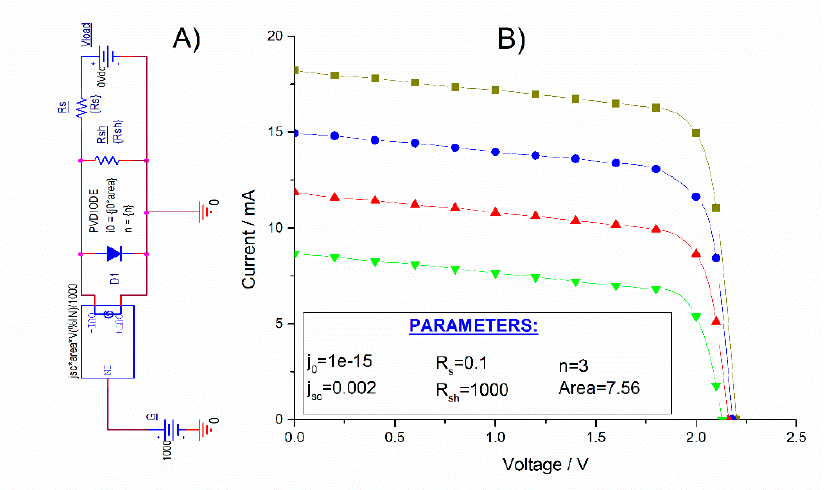
Figure 6. ( A ) Equivalent circuit used for the modeling of organic solar cells. ( B ) Generated I–V curves for different irradiance values: Green line (600 Wm − 2 ), red line (800 Wm − 2 ), blue line (STC 1000 Wm − 2 ), and yellow line (1200 Wm − 2 ). Inset: Parameters used for generating the corresponding I–V curves.